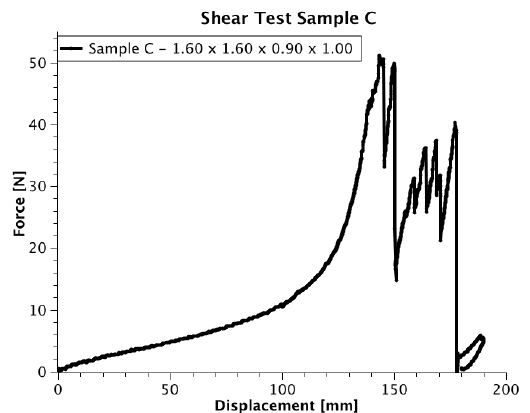
Figure 9. Raw-data of sample C; force F is plotted over displacement x .